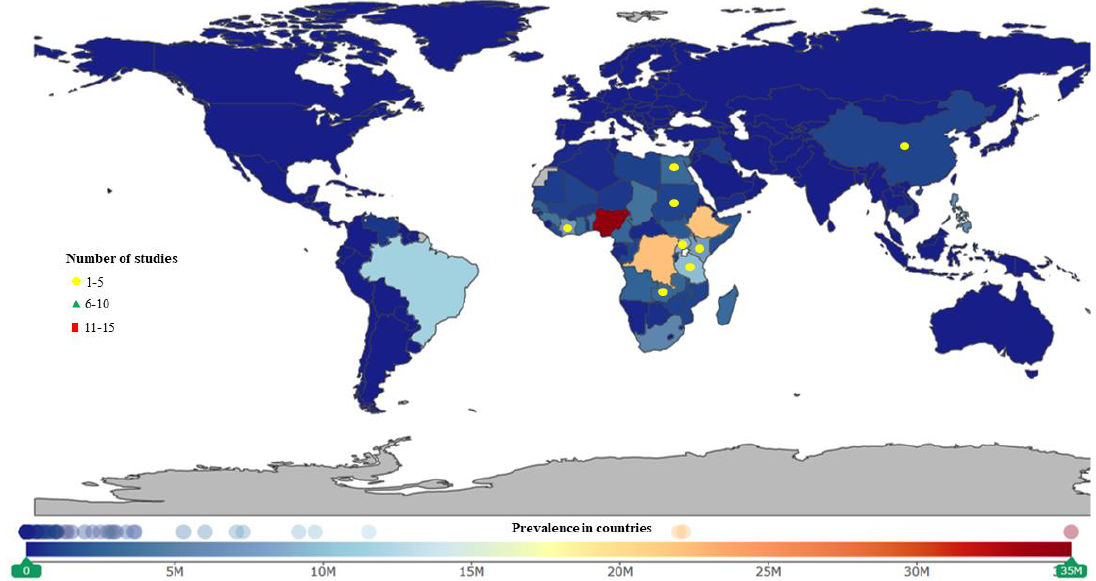
Figure 6. Schistosomiasis studies were mostly conducted in Africa. Egypt and Cote d’Ivoire had the most studies. Nigeria, the DRC, and Ethiopia have the highest prevalence.